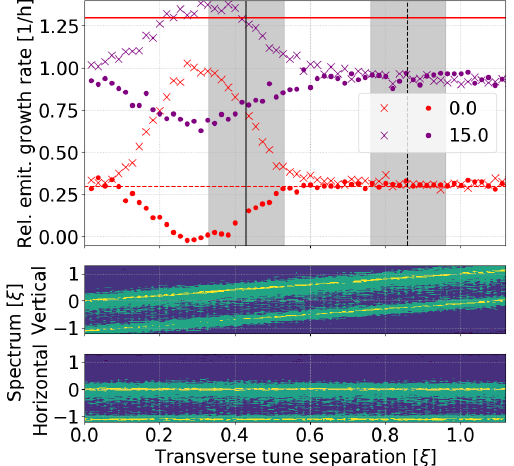
FIG. 6. Relative emittance growth rate (upper plot) as a function of the tune separation between the two transverse planes for different chromaticities. The feedback gain is set to 5 × 10 − 3 . The predictions of the weak-strong and strong-strong models are shown with a solid and dashed red lines respectively. The lower plots show the transverse spectrum of the beam obtained by Fourier transform of the turn-by-turn position at the IP showing that the variation of the tune separation is obtained by increasing the vertical tune. The fractional part of the horizontal tune is kept at 0.31 for all simulations. The numerical parameters for the simulations are listed in Table I. The measured tune separation values during the experiments described in the next section are shown with a dashed and a solid black line with a shaded area representing the uncertainty. They correspond respectively to the data shown in Figs. 7 and